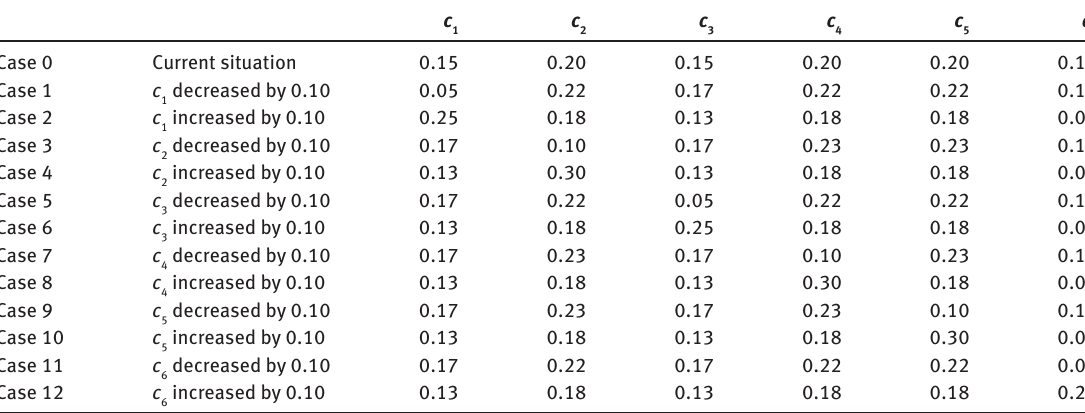
Table 13: Sensitivity Analysis for Criteria Weights.